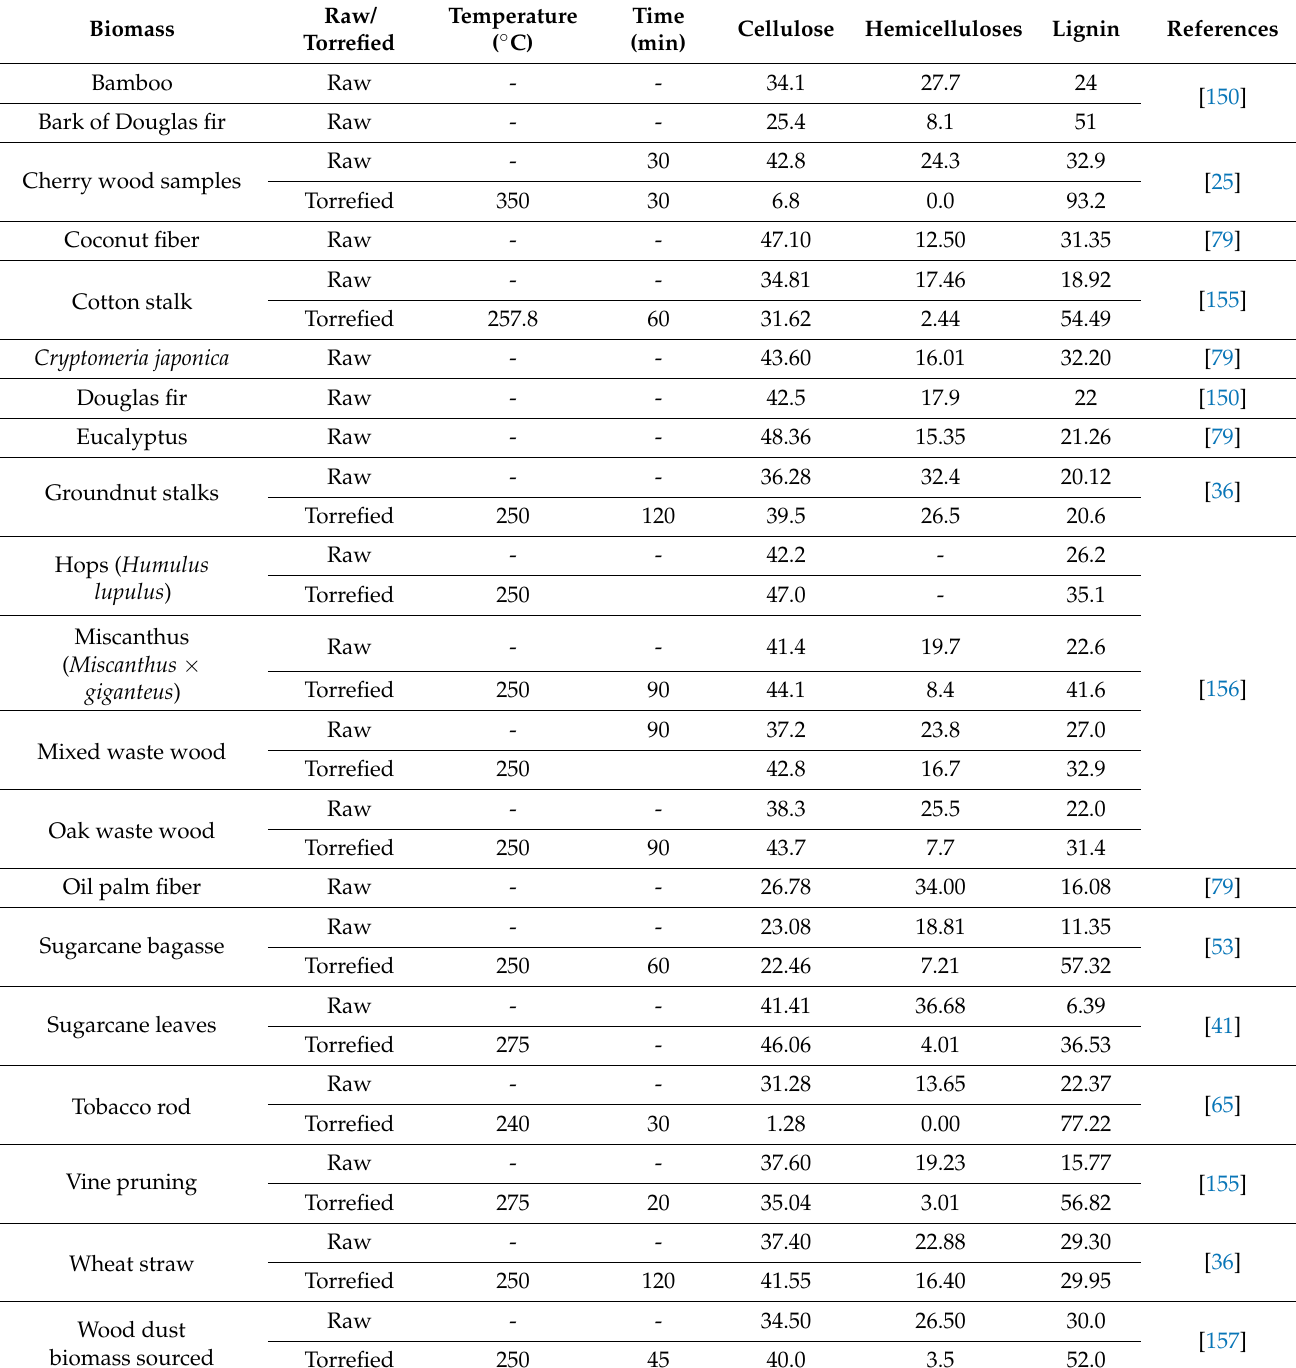
Table 1. Raw and dry-torrefied lignocellulosic biomass